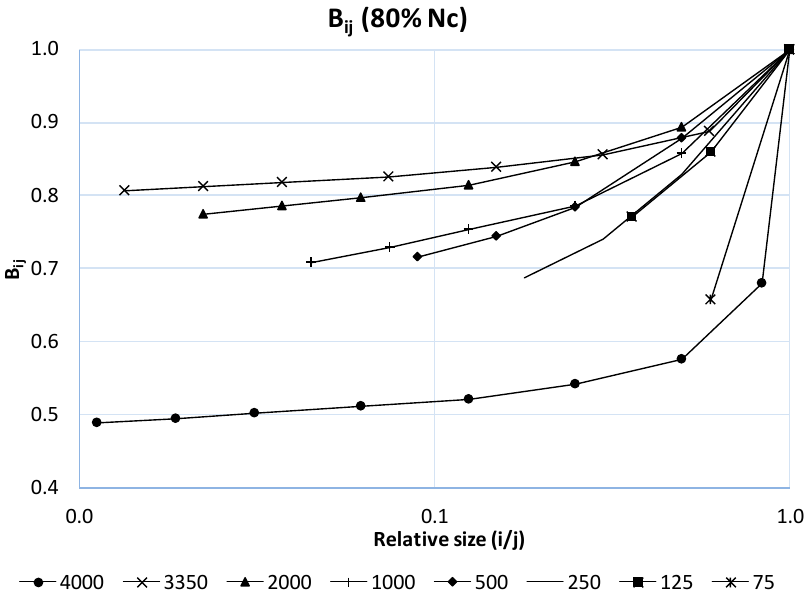
Figure 6. Behavior of the fracture function ( B ij ), with respect to particle size. 80% working speed Nc (Barruecopardo ore).